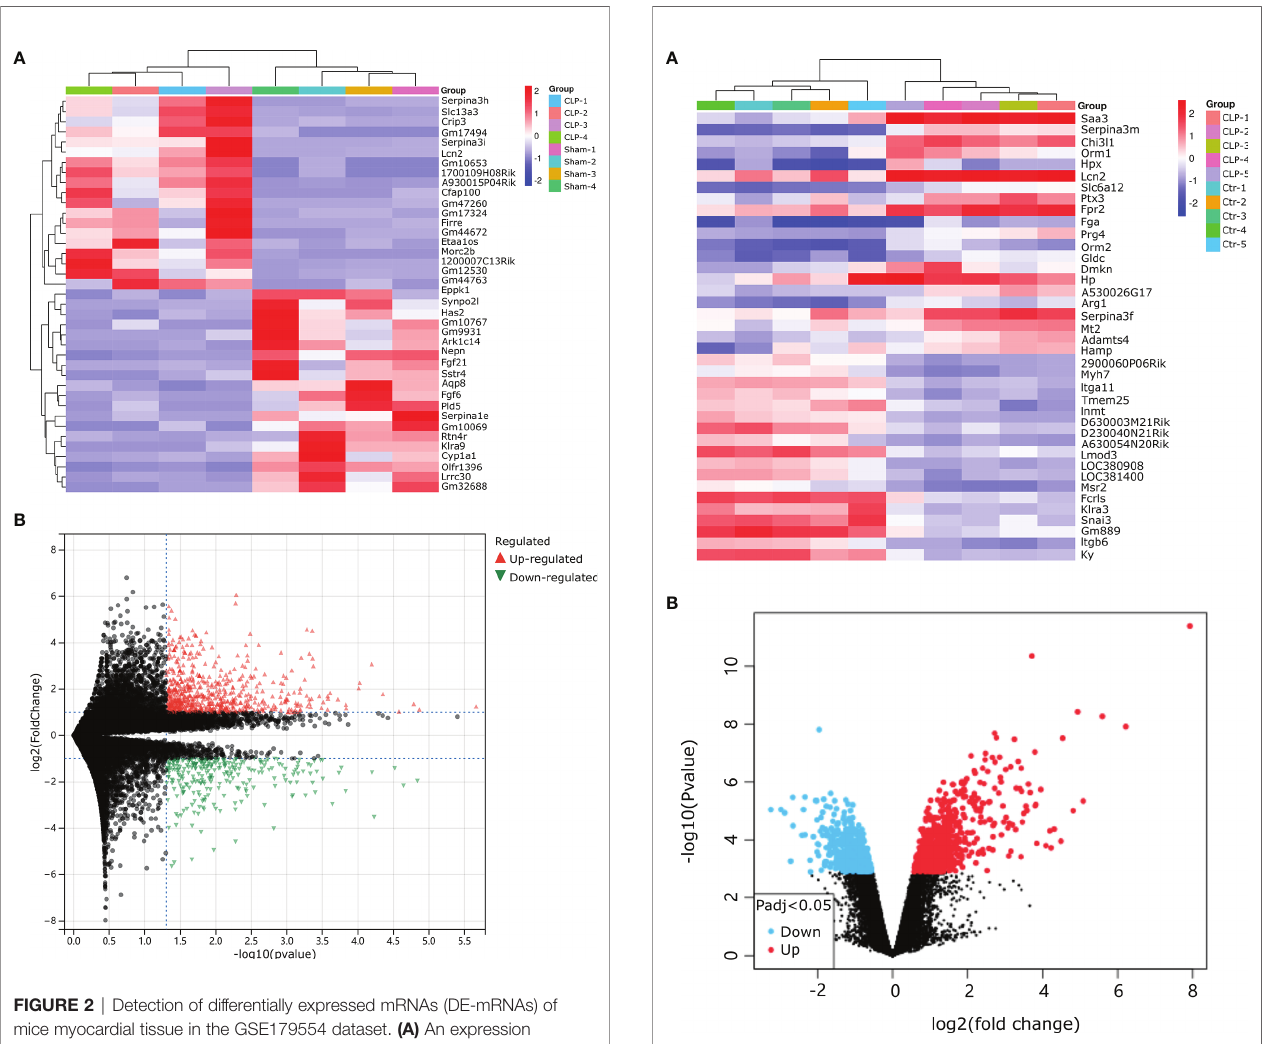
FIGURE 3 | Detection of differentially expressed mRNAs (DE-mRNAs) of mice myocardial tissue in the GSE40180 dataset. (A) An expression heatmap corresponding to the expression pro fi le of mRNAs in the mice myocardial tissue. (B) A volcano plot corresponding to the expression pro fi le of mRNAs in the mice myocardial tissue. The red plots represent upregulated genes, the black plots represent nonsigni fi cant genes, and the blue plots represent downregulated genes.